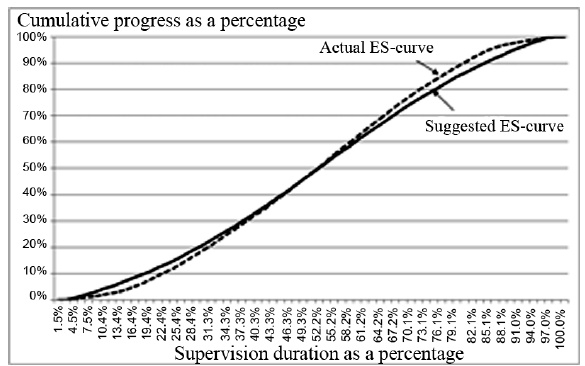
Fig. 5. Actual and suggested ES-curves of the testing project during the planning